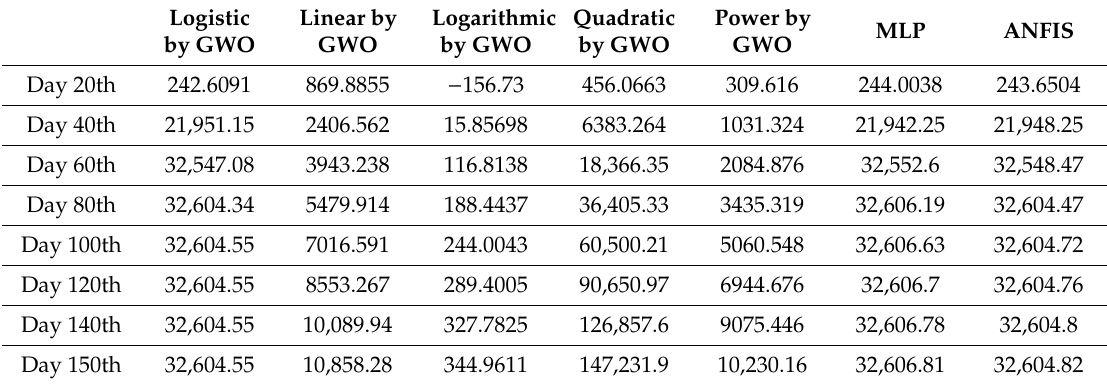
Table 21. The outbreak prediction for the USA for 150